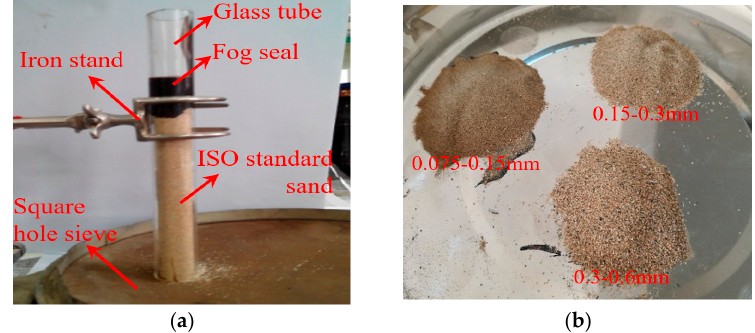
Figure 5. Penetration test: ( a ) device; ( b ) ISO standard sand.